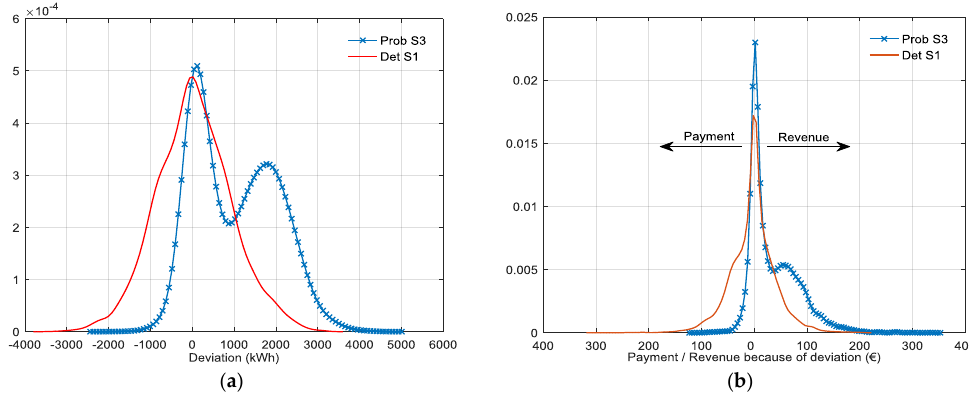
Figure 6. ( a ) Approximate probability density functions (PDF) of the energy deviation after the day-ahead market; ( b ) PDF of the payment/revenue due to deviation after the day-ahead market.